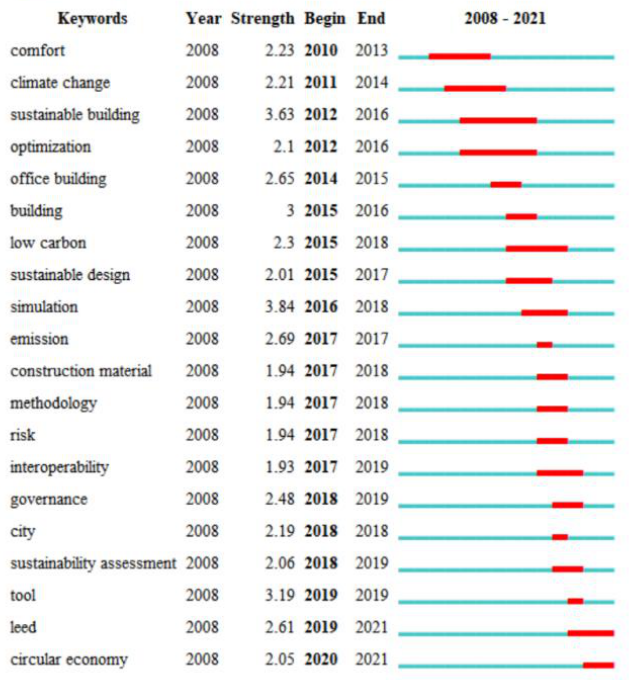
Figure 7. The 20 keywords with the strongest citation bursts in articles on BIM in the field of carbon emissions for sustainable buildings from 2008 to 2021 via CiteSpace software (generated by the authors).